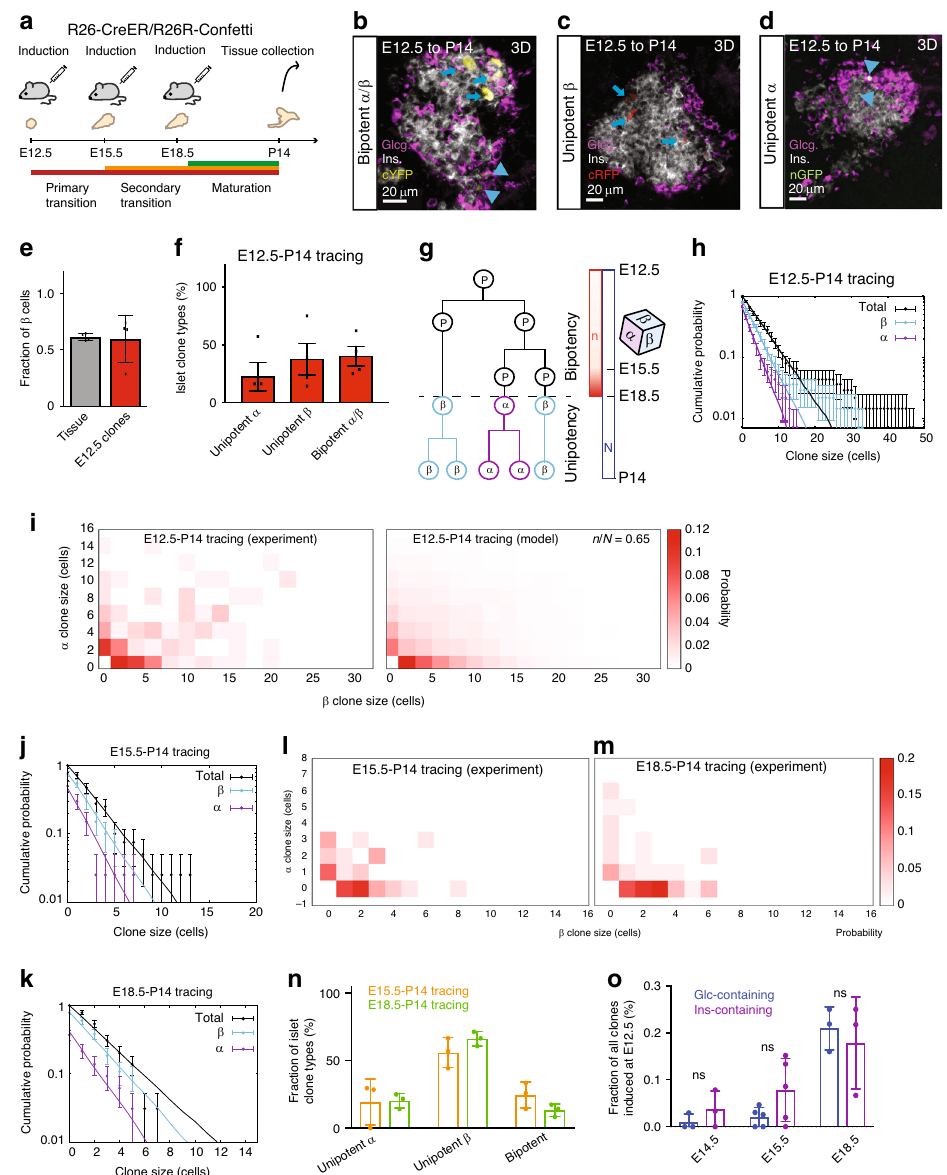
Fig. 4 Islet cells originate from bipotent islet progenitors that become sublineage-restricted. a Experimental schedule. Representative images from 4 experiments of b bipotent, c unipotent β -cell, and d unipotent α -cell clone (based on >60, 45, >20 recorded images, respectively). Insulin is grey, glucagon is pink. Arrows (arrowheads) indicate insulin + (glucagon + ) cells. e Fraction of β -cells (normalised to α + β -cell number) at P14 in islets ( n = 36 islets from N = 4 mice) and clones traced from E12.5 to P14 ( n = 138 clones from N = 4 mice; mouse with low ratio contained only 7 clones), quanti fi ed volumetrically from 100 μ m section. Error bars show average ± SD. f Percentage of clone types ( n = 138 clones from N = 4 mice). Error bars show average ± SEM. g Typical model lineage ( “ Methods ” ): following endocrine commitment, progenitors undergo average of n rounds of stochastic division after which they become sublineage-restricted choosing randomly between α - or β -cell fate in ratio 1:2 (cf. “ loaded dice ” ). Between E12.5 and P14, islet progenitors and progeny undergo average of N rounds of division. For simplicity, model excludes differentiation into minority sublineages. h Cumulative size distribution of islet clones traced from E12.5 to P14 disaggregated by composition (total black, α -cell purple and β -cell blue). Data shown as dots ( n = 138 clones from N = 4 mice, error bars show average ± SD) and fi tted model predictions as lines. i Joint distribution of α - and β -cell numbers in islet clones from E12.5 to P14 tracings from data (left) and model (right) (main text and Methods). Cumulative size distribution of islet clones (key as in h ) traced from j E15.5 to P14 ( n = 40 clones from N = 3 mice) and k E18.5 to P14 ( n = 65 clones from N = 3 mice). Joint distribution of α - vs. β -cell numbers in clones traced from l E15.5 and m E18.5 (cf. model prediction in Supplementary Fig. 5a, b). n Percentage of clone types traced from E15.5 to P14 ( n = 40 clones from N = 3 mice) and